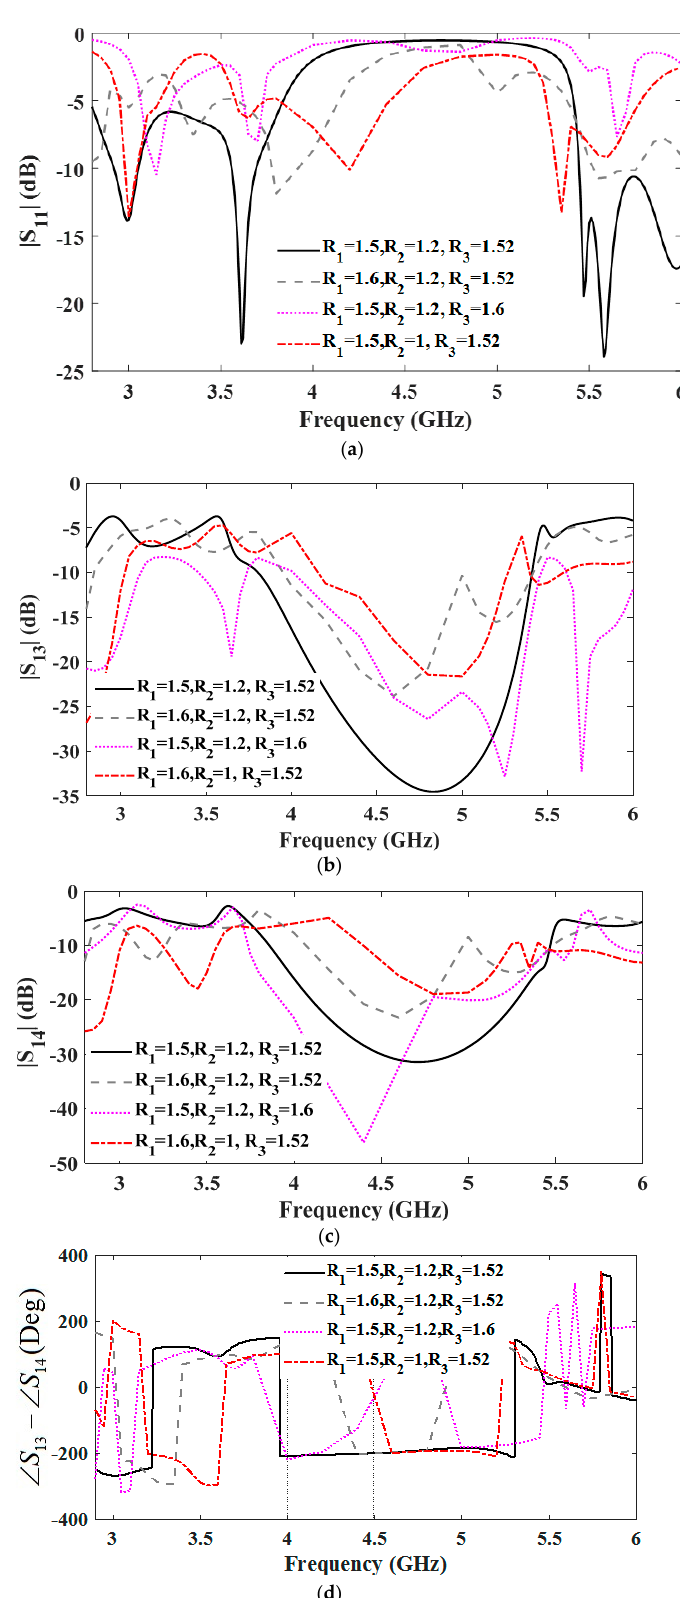
Figure 5. ( a ) Accurate circuit model of the proposed coupler with artificial TLs based on OSRR with the obtained elements values, ( b ) amplitude response of the S-parameters of the coupler by using the circuit and EM simulations: ( c ) phase difference of the outputs of the proposed coupler.